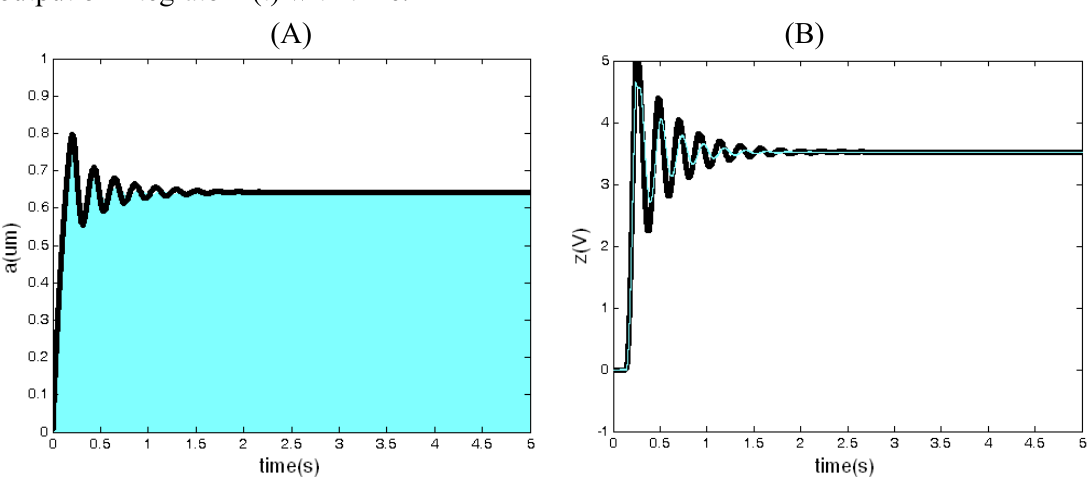
Figure 7. Closed-loop response (gray) and averaged equation simulation (black) when V V   . (A) The curve of the drive displacement with time. (B) The curve of the 0.3 ref refo output of integrator z(t) with time.